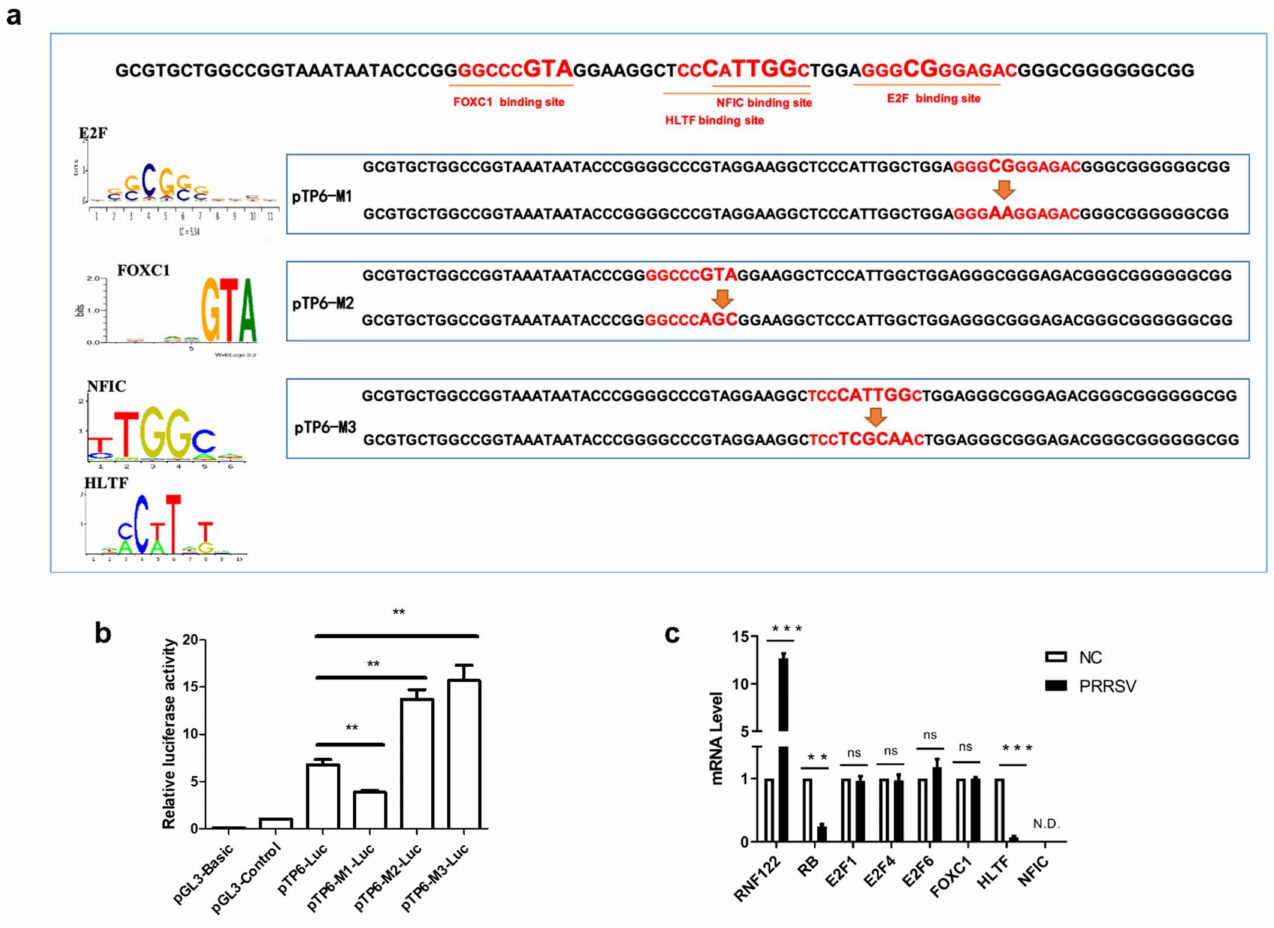
Figure 3. E2F complex and HLTF were identified as key transcription factors in porcine RNF122. ( a ) Schematic diagram of transcription factor binding site mutation in RNF122 core promoter region. ( b ) HEK293T cells were co-transfected with mutant plasmids of pTP6-Luc and RL-TK,